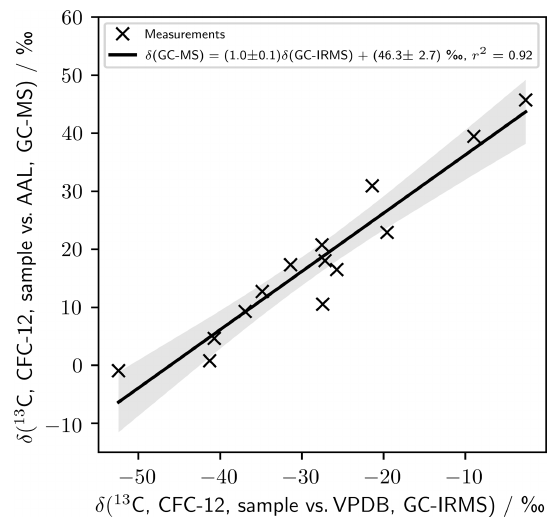
Figure B1. Comparison of measurements presented by Zuiderweg et al. (2012) using GC–IRMS (Zuiderweg et al., 2011) to our own measurements of those same samples.